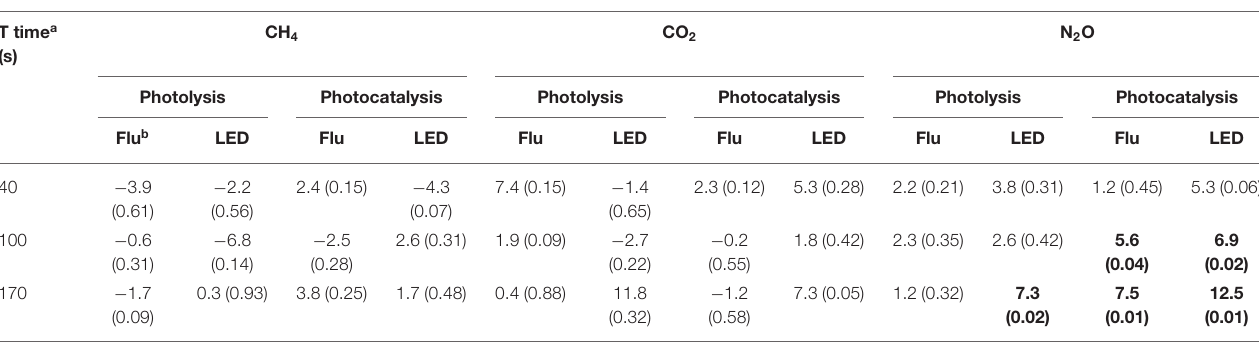
TABLE 5 | Comparison of greenhouse gas